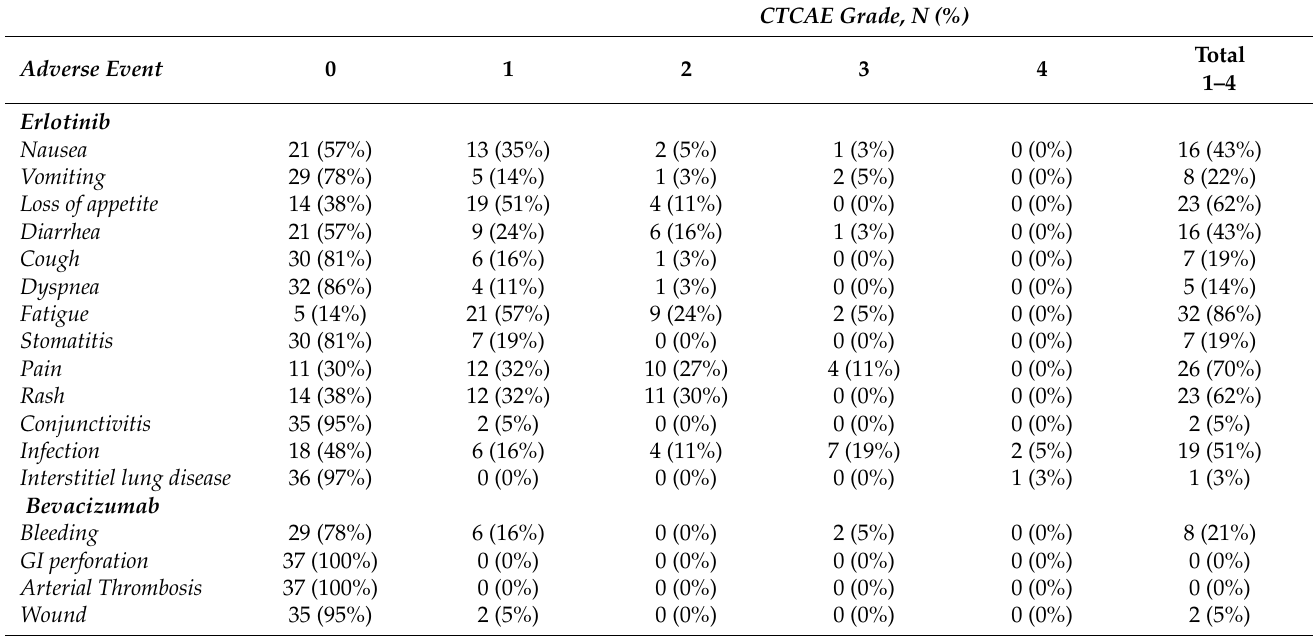
Table 3. Adverse events of erlotinib and bevacizumab in Patients with Biliary Cancer ( n = 37). CTCAE Grade, N